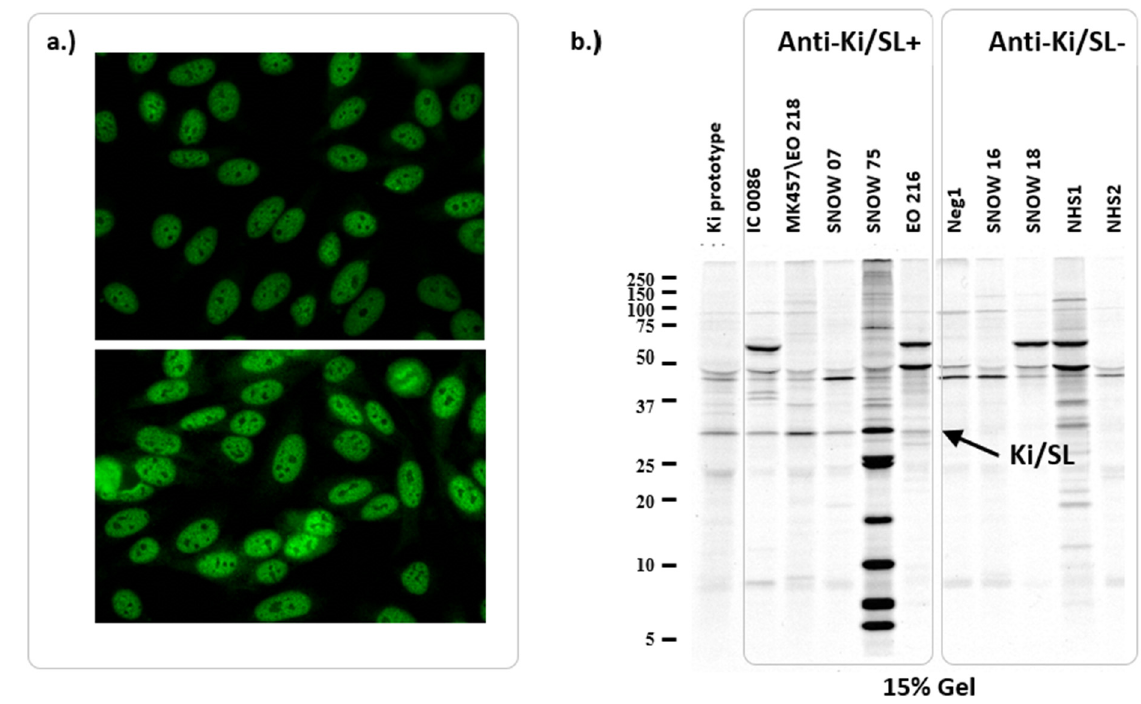
Figure 3. Detection methods for anti-Ki/SL antibodies. ( a ). Indirect immunofluorescence patterns on HEp-2 slides showing a nuclear speckled pattern. ( b ). Immunoprecipitation pattern shows the immunoprecipitation (IP) bands associated with the presence of anti-Ki/SL antibodies.